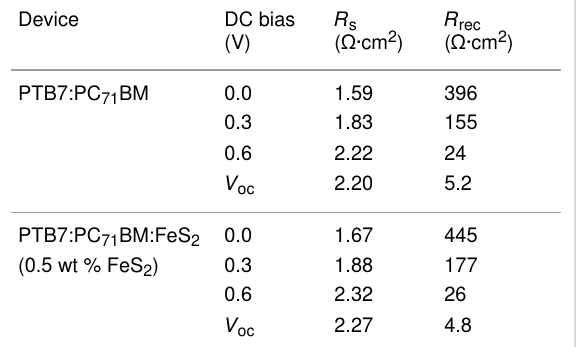
Table 2: Parameters of the equivalent circuit used to simulate the ex- perimental IS data of PTB7:PC 71 BM and PTB7:PC 71 BM:FeS 2 (0.5 wt % FeS 2 ) based solar